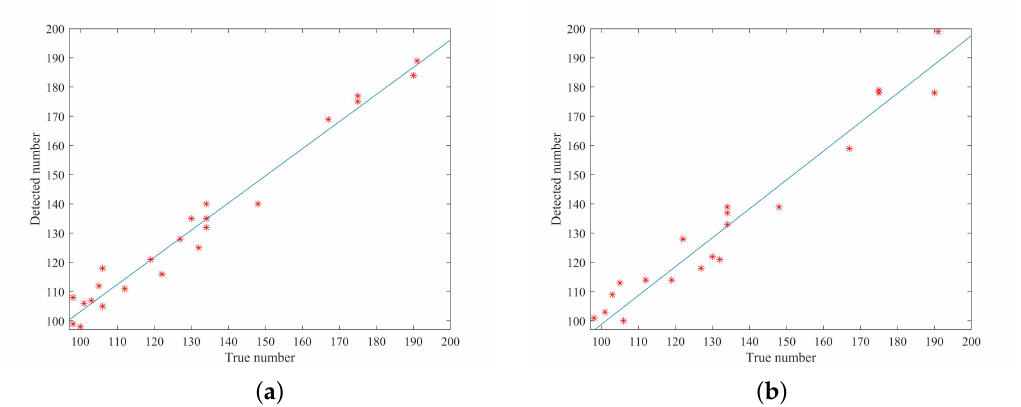
Figure 5. Fitted results of detected ear numbers versus true ear numbers. ( a ) Fitted results by the proposed algorithm. ( b ) Fitted results by